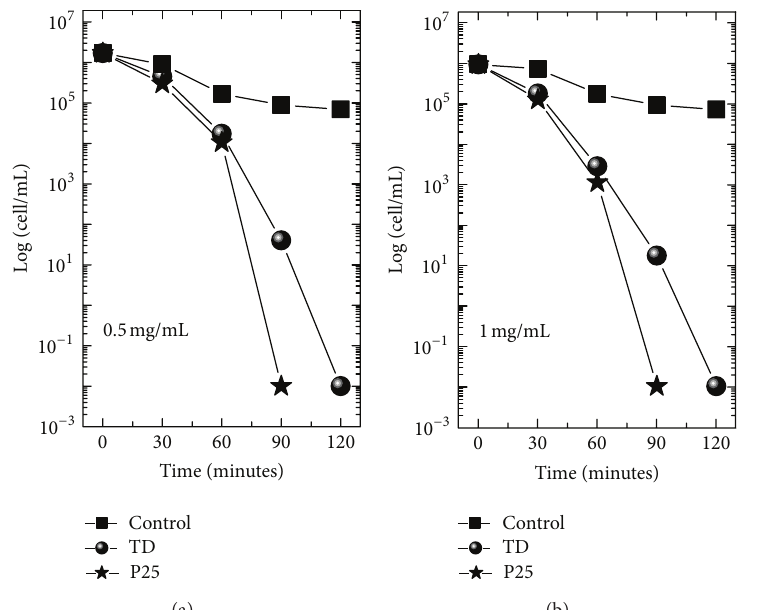
Figure 4: Effect of light and TiO 2 concentration on viability of the Pseudomonas aeruginosa ATCC 27853 exposed to (a) 0.5 mgmL −1 TD and P25 and (b) 1mgmL −1 TD and P25. In both plots, the control data (light exposure without TD and P25) are displayed as black squares.